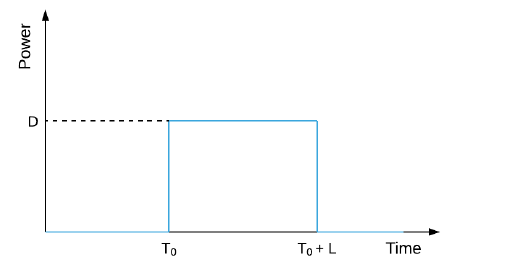
Figure 9. Characterization of the power demanded by a consumption